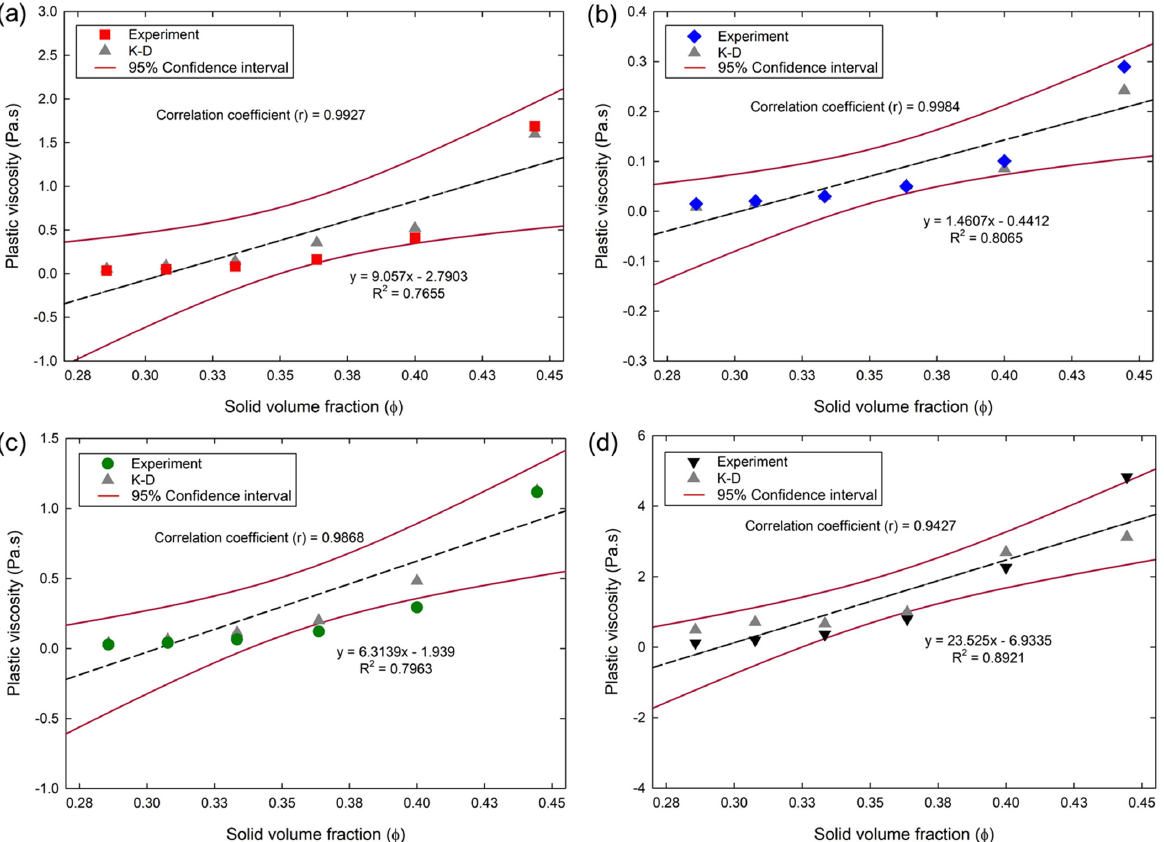
Figure 8. Plastic viscosity of cementitious suspensions in K–D predictions and experiments: ( a ) PC; ( b ) FA; ( c ) BS; ( d ) SF.